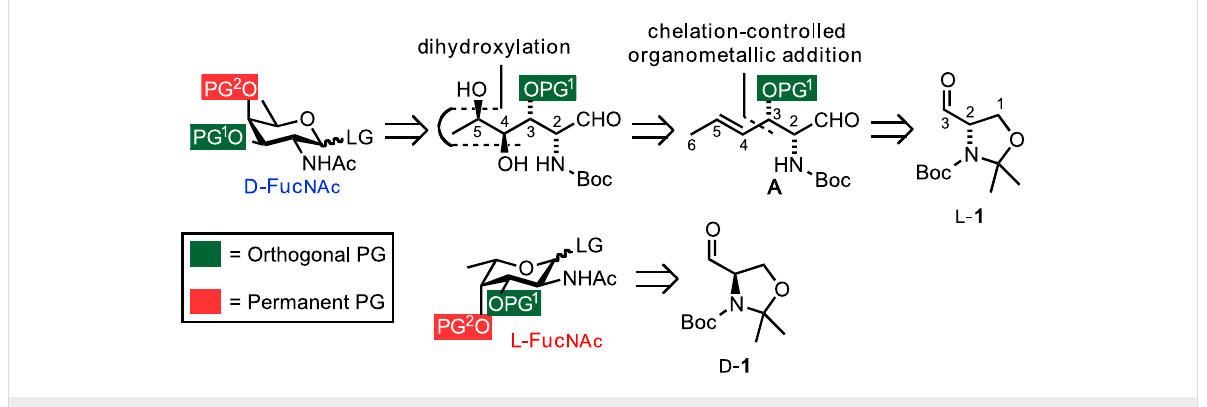
Scheme 1: Retrosynthetic analysis of D- and L-fucosamine building blocks.